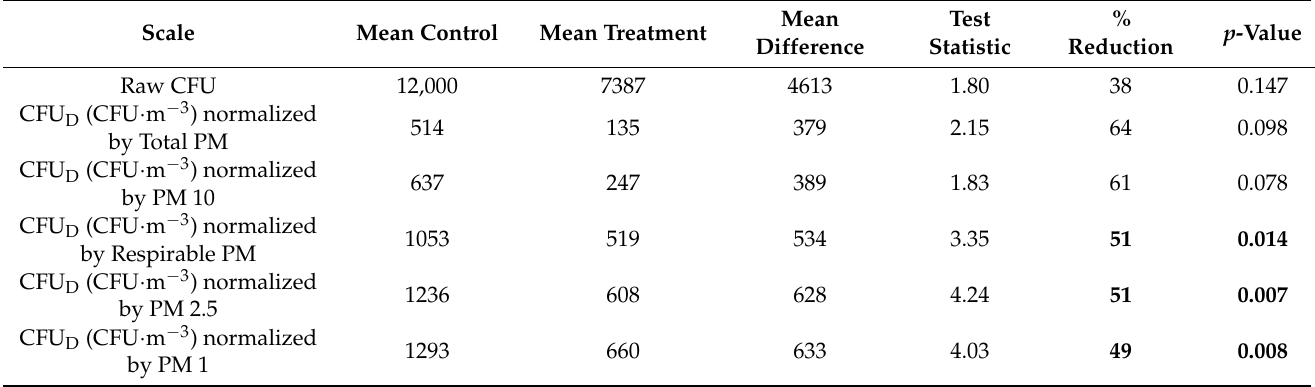
Table 6. CFU removal performance of UV-A photocatalysis (Treatment II) in mitigating airborne pathogens. Comparison of CFU D (CFU · m − 3 ) normalized by the different particle size (total, PM 10, PM respirable, PM 2.5, PM 1) concentrations ( µ g · m − 3 ) before and after UV-A photocatalysis (CFU PM , CFU · µ g − 1 ). Bold signifies statistical